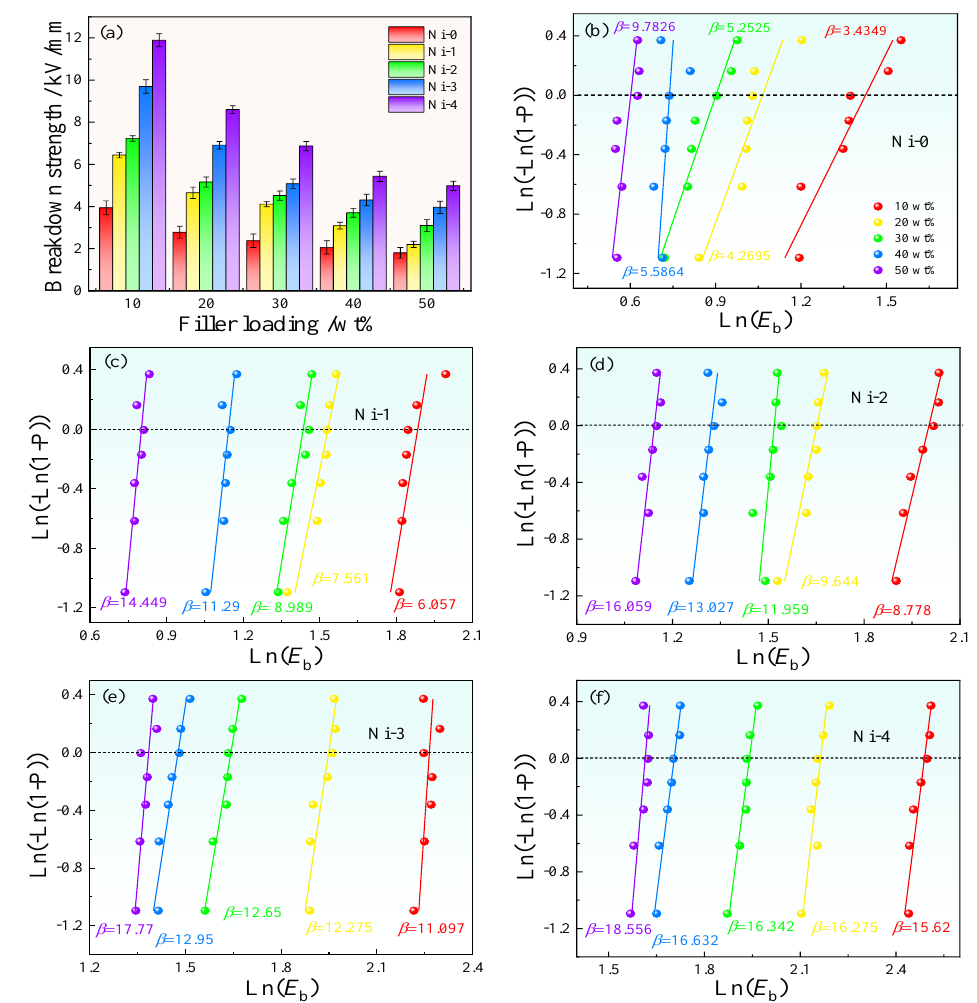
Figure 10. ( a ) The E b changes with various filler concentrations for five composites, ( b – f ) the Weibull distribution for Ni–0~Ni–4/PVDF composites.